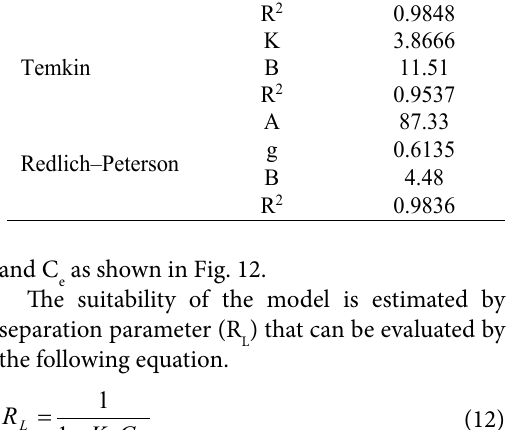
Table 8. Parameters related to Isotherms models for MB adsorption by SD/MgO with non-linear method (C o = 50-160 mg L - 1